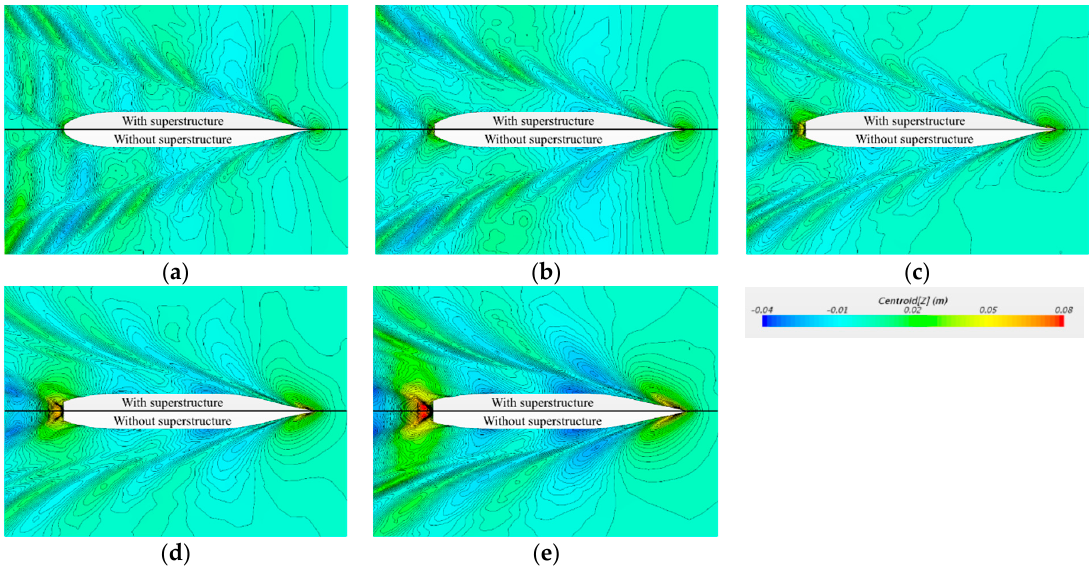
Figure 7. Comparison of wave pattern between the 8000 TEU container ship with superstructure and without superstructure. ( a ) 𝐹 𝑁 0.165 , ( b ) 𝐹 𝑁 0.192 , ( c ) 𝐹 𝑁 0.219 , ( d ) 𝐹 𝑁 0.247 , and ( e ) 𝐹 𝑁 0.274 .